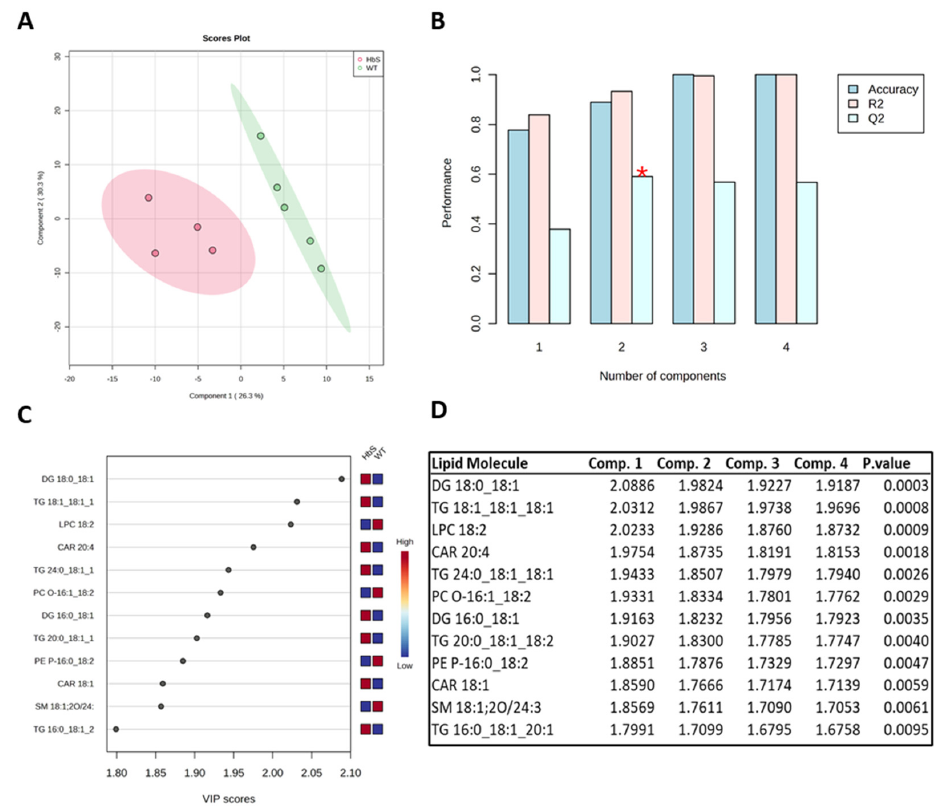
Figure 2. Multivariate statistical analysis of lipid species in HbS and WT erythrocytes: ( A ) PLS-DA. ( B ) Cross Validation test. ( C ) VIP (Variable Importance in Projection) plot; the colored boxes on the right indicate the relative concentrations of the corresponding lipid in each group under study. ( D ) Table of the VIP score in each component and p -values for the individual lipids in the VIP